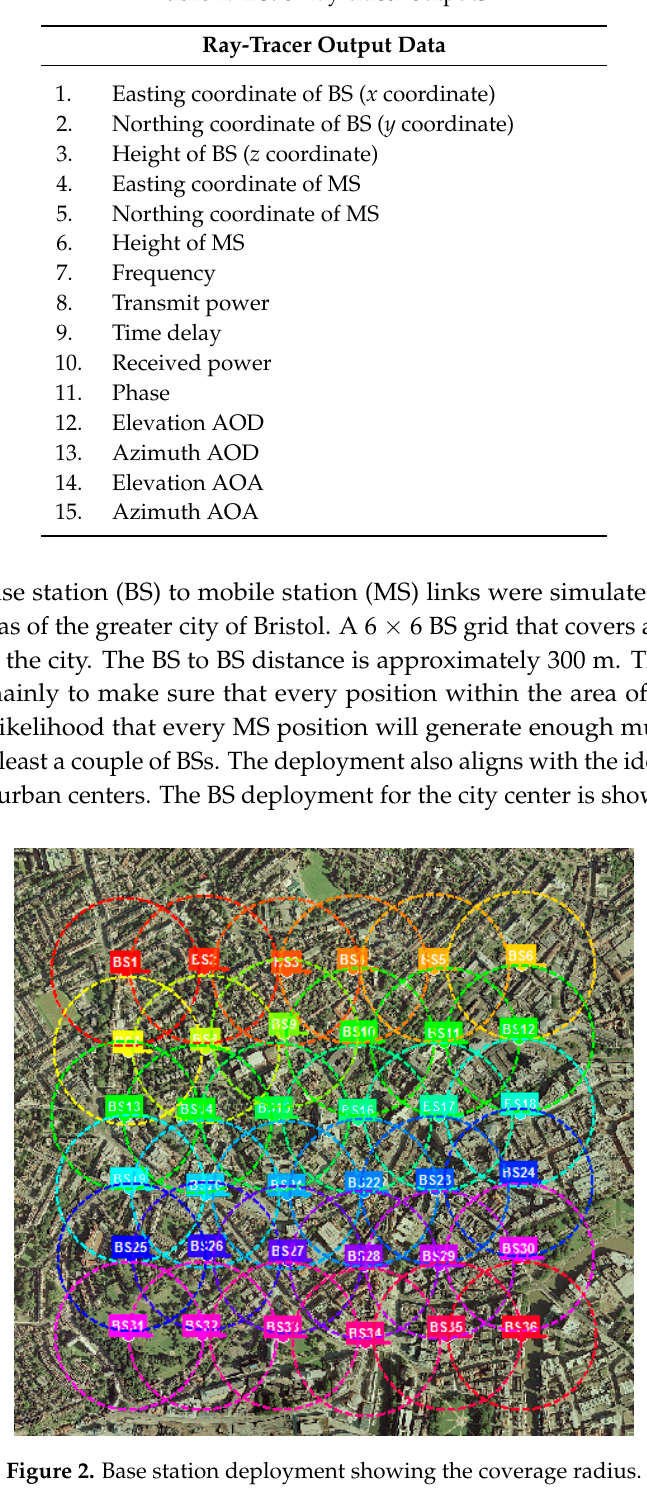
Table 1. List of ray-tracer outputs.